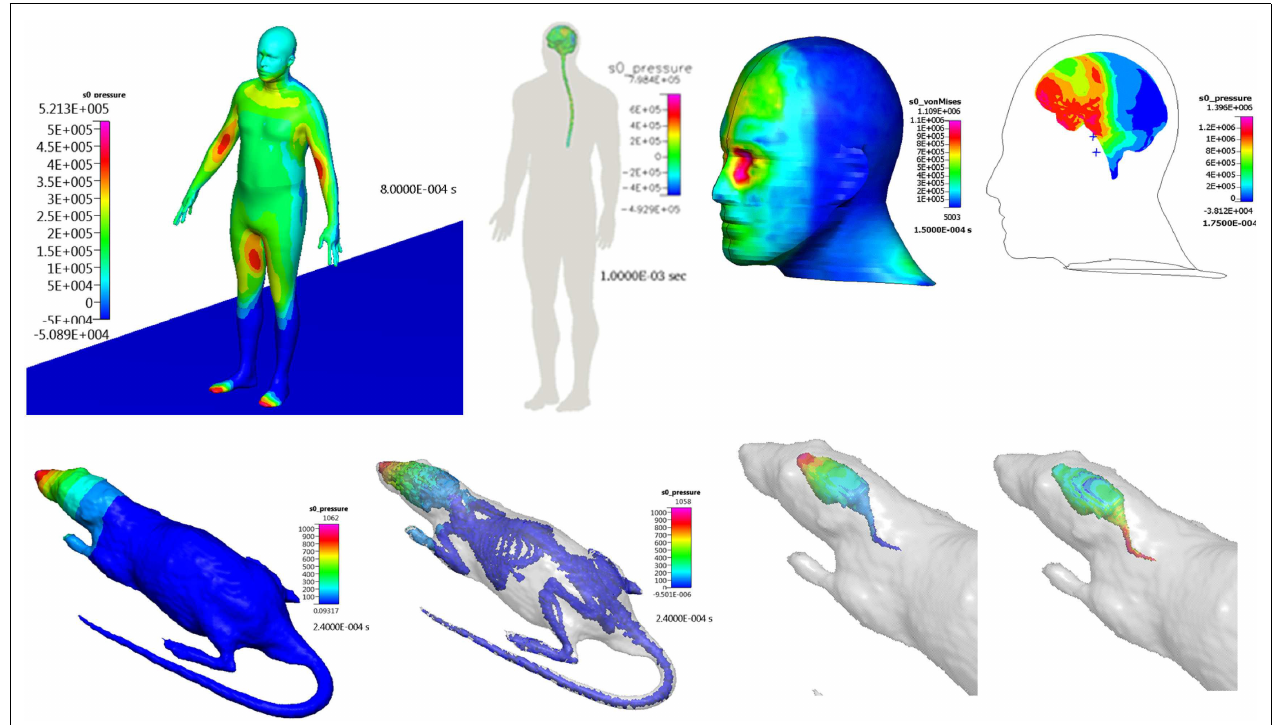
FIGURE 7 | 3DAnatomical/geometric models of a human body and head, and a virtual rat